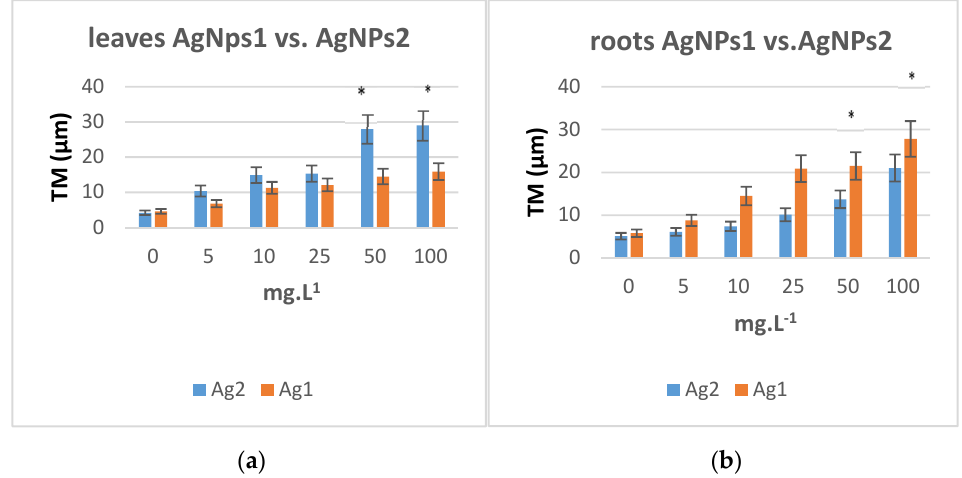
Figure 3. ( a ) The averaged median tail moments (TM) in leaf nuclei after a 24 h treatment at 26 °C of 4–5 weeks old tobacco ( N. tabacum ) plants with aqueous solutions of AgNPs. ( b ) The averaged median tail moments (TM) in root nuclei after a 24 h treatment at 26 °C of 4–5 weeks old tobacco ( N. tabacum ) plants with aqueous solutions of AgNPs (size AgNPs1 12–15 nm and AgNPs2 22–25 nm) The error bars represent the standard error of the mean. (*) Significantly ( p < 0.05) different from the control.